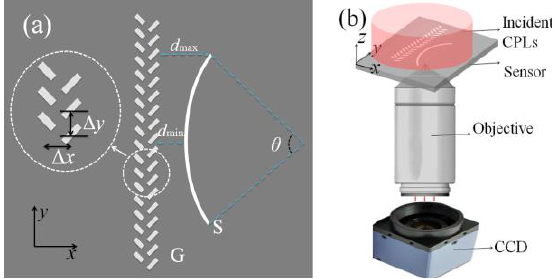
Figure 1. ( a ) Structure diagram of the designed plasmonic sensor at x − y plane, two parallel columns of spatially arranged rectangular nanogrooves (named ‘G’) and a micron length circular arc slit (named ‘S’) are etched into a thin silver film with thickness of 150 nm, ∆ x = 0.153 µ m, ∆ y = 0.2 µ m, d min = 0.9 µ m, d max = 1.9 µ m, θ = 40 ◦ . ( b ) Schematic diagram of a reference functional testing optical path for detecting the chirality of the incident CPLs in the actual experiment.